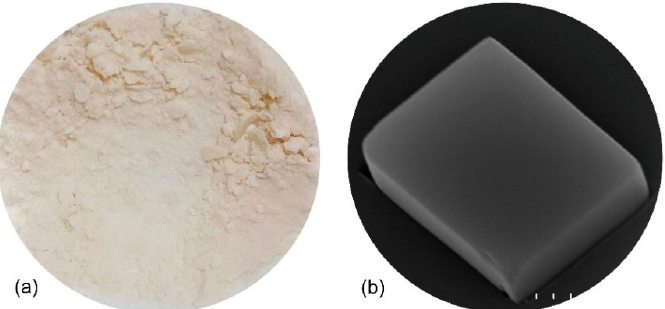
Figure 2. ( a ) Collected precipitated crystals from shale flask and ( b ) SEM micrograph of the collected precipitates from shake flask.